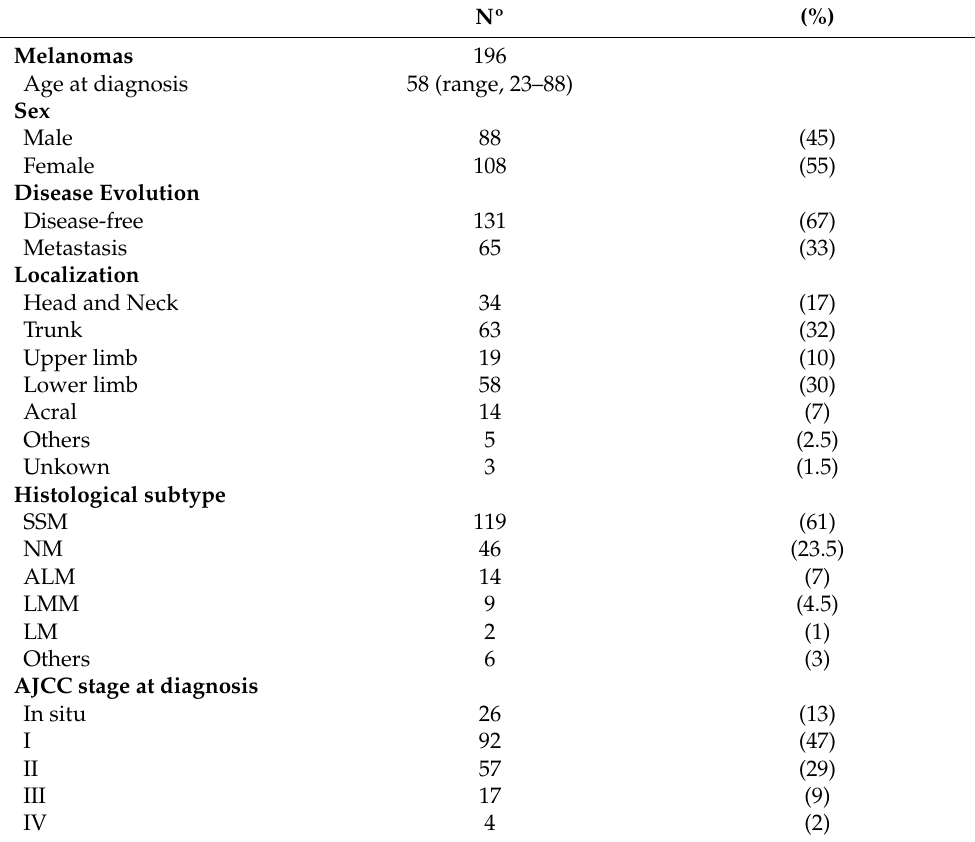
Table 1. Clinical data of melanoma